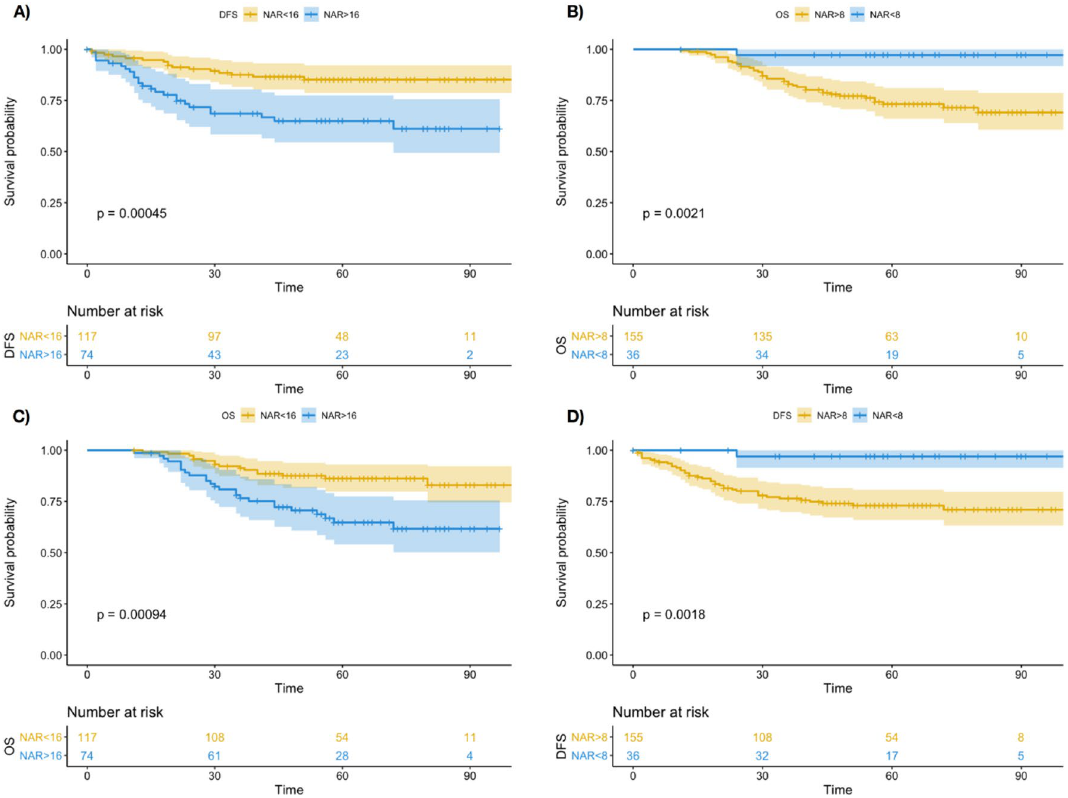
Figure 2. The Kaplan–Meier Survival Curve for ( A ) DFS for NAR > 16 versus NAR < 16, ( B ) OS for NAR > 8 versus NAR < 8, ( C ) OS for NAR < 16 versus NAR > 16 and ( D ) DFS for NAR > 8 versus NAR <